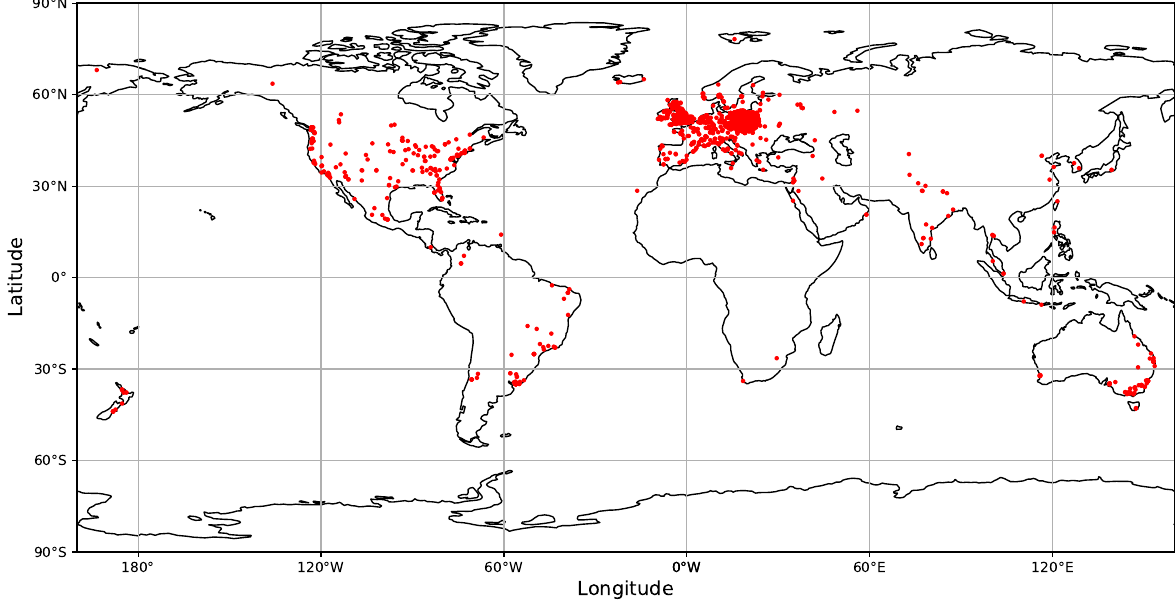
Figure 1. Locations of CREDO registered phone-based